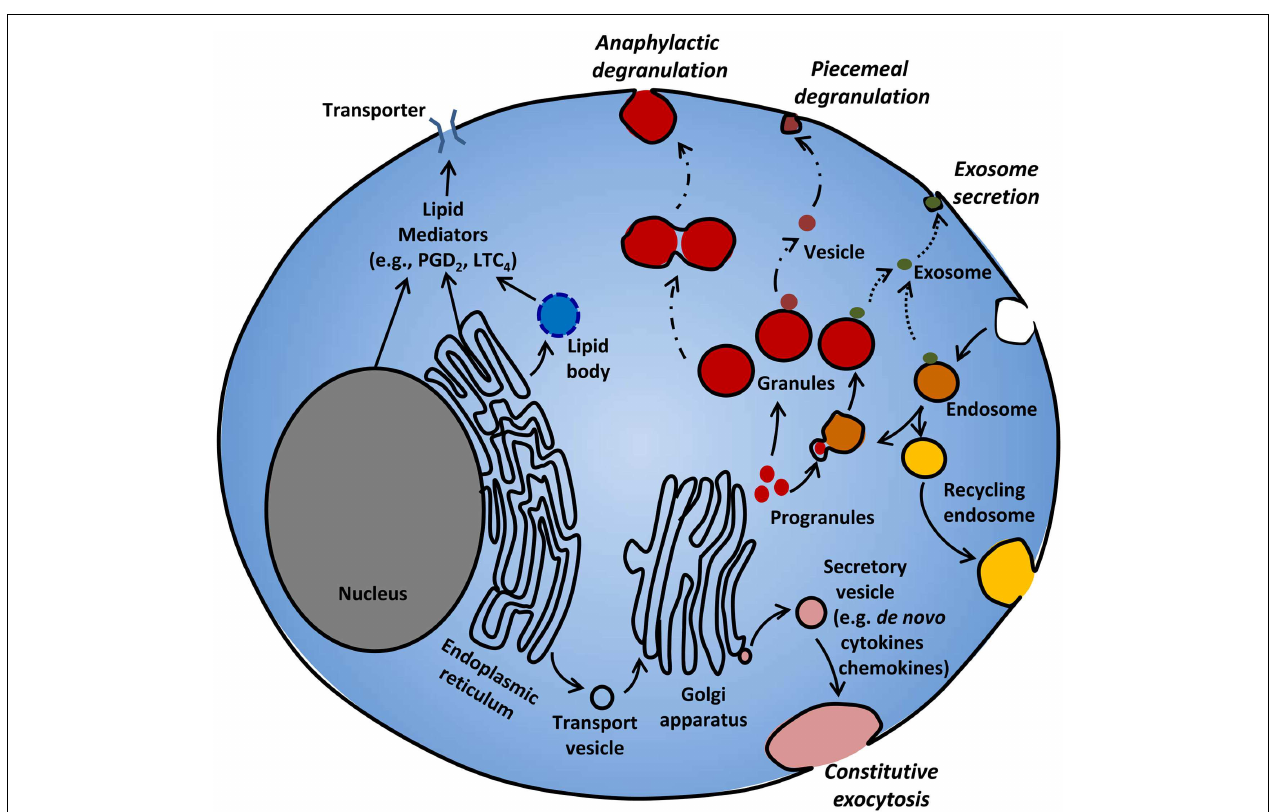
and endosomes through exosomal secretion. Lipid mediators such as PGD 2 and LTC 4 are synthesized in lipid bodies, nuclear and ER membranes, and released through active transporters. De novo synthesized cytokines and chemokines packaged in secretory vesicles are released through constitutive exocytosis.